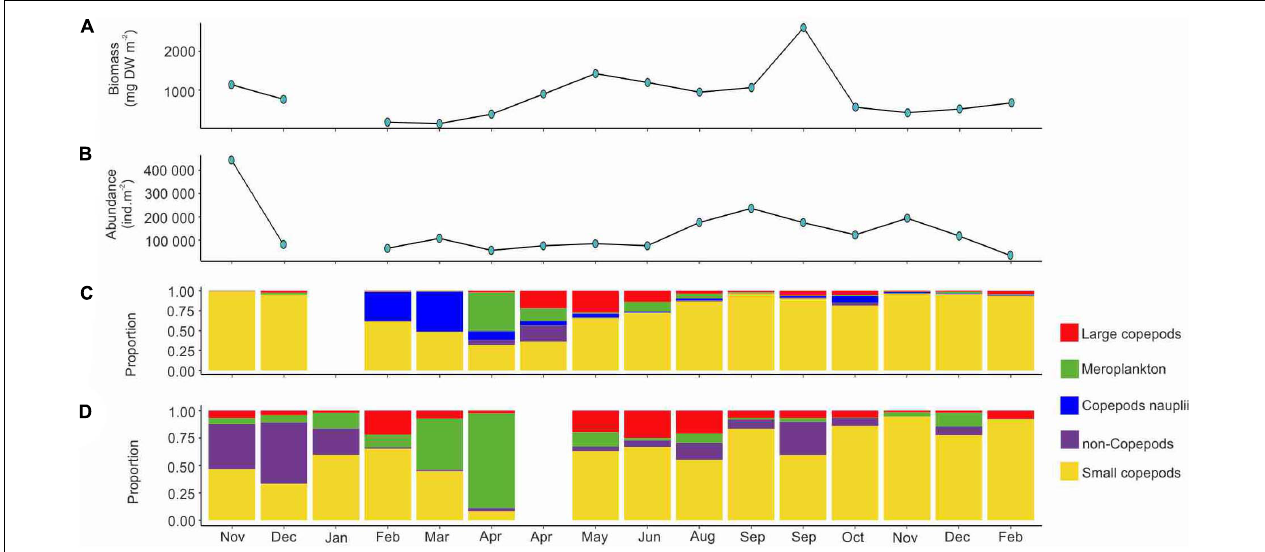
FIGURE 3 | Seasonal changes in the total zooplankton biomass (A) , total zooplankton abundance (B) , proportions of main taxonomic groups based on morphological analysis (C) , and metabarcoding (D) in Ramfjord during November 2018–February 2020.